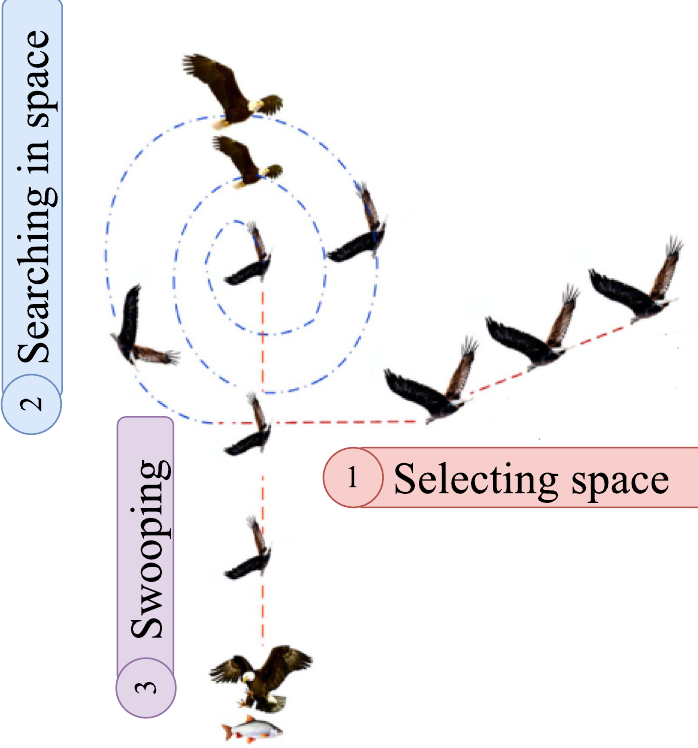
Fig. 2 Steps of bald eagle hunting in